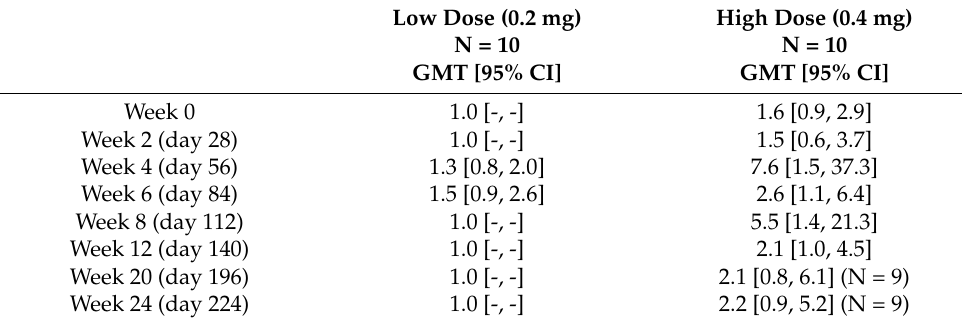
Table 4. GMT of neutralizing activity (ID50) against SARS-CoV-2 pseudoviruses.